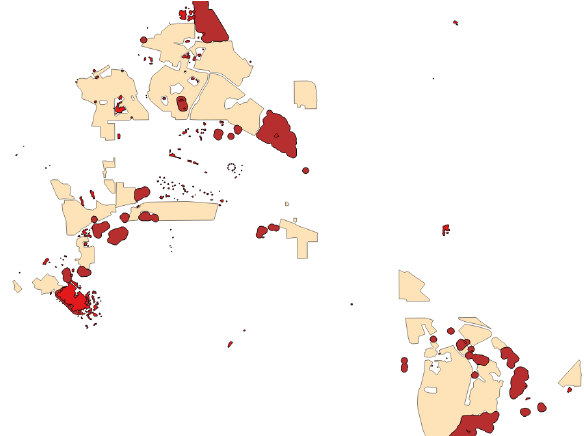
Figure 13. Processed OSM built-up features (light orange), OSM buildings (red) and OSM highways (brown) for Darwin, Australia